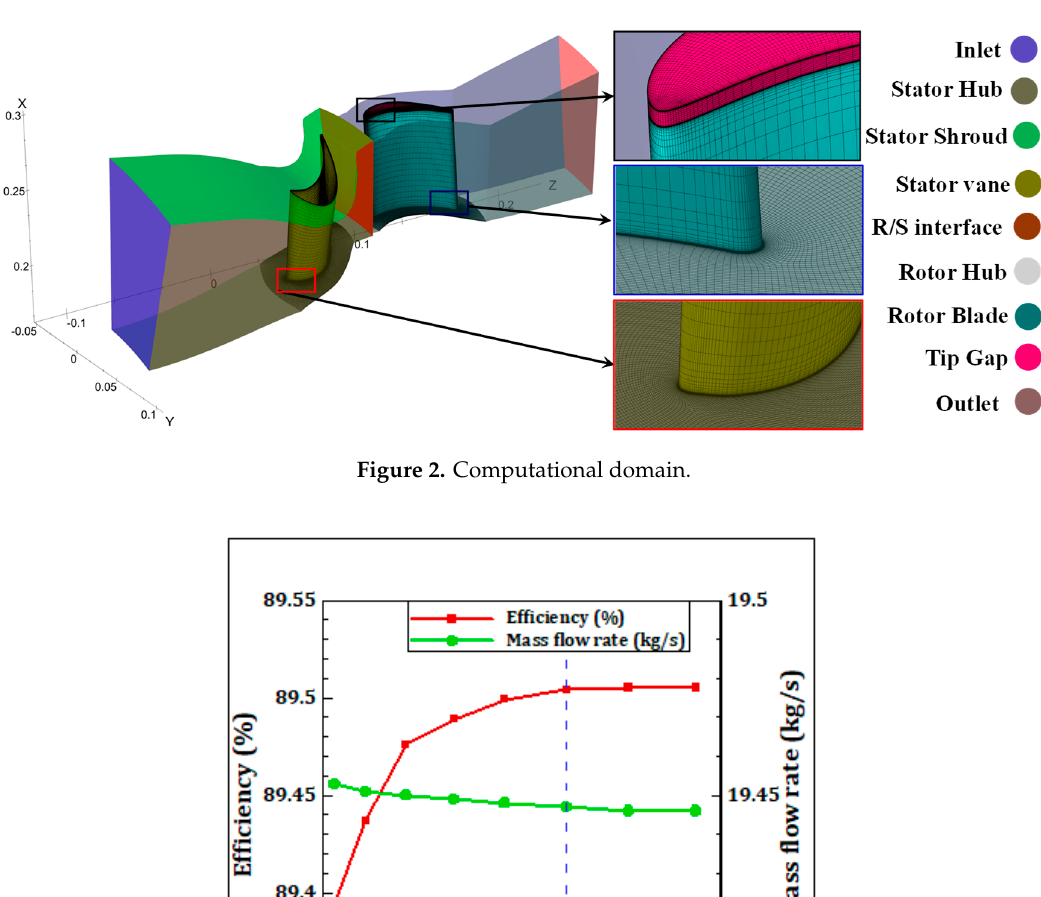
Figure 3. Grid dependency: Plot of mass flow and efficiency.